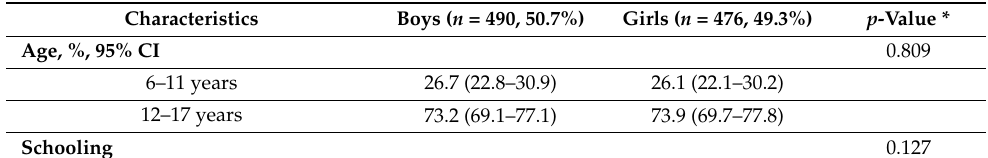
Table 2. Characteristics of the study population ( n =